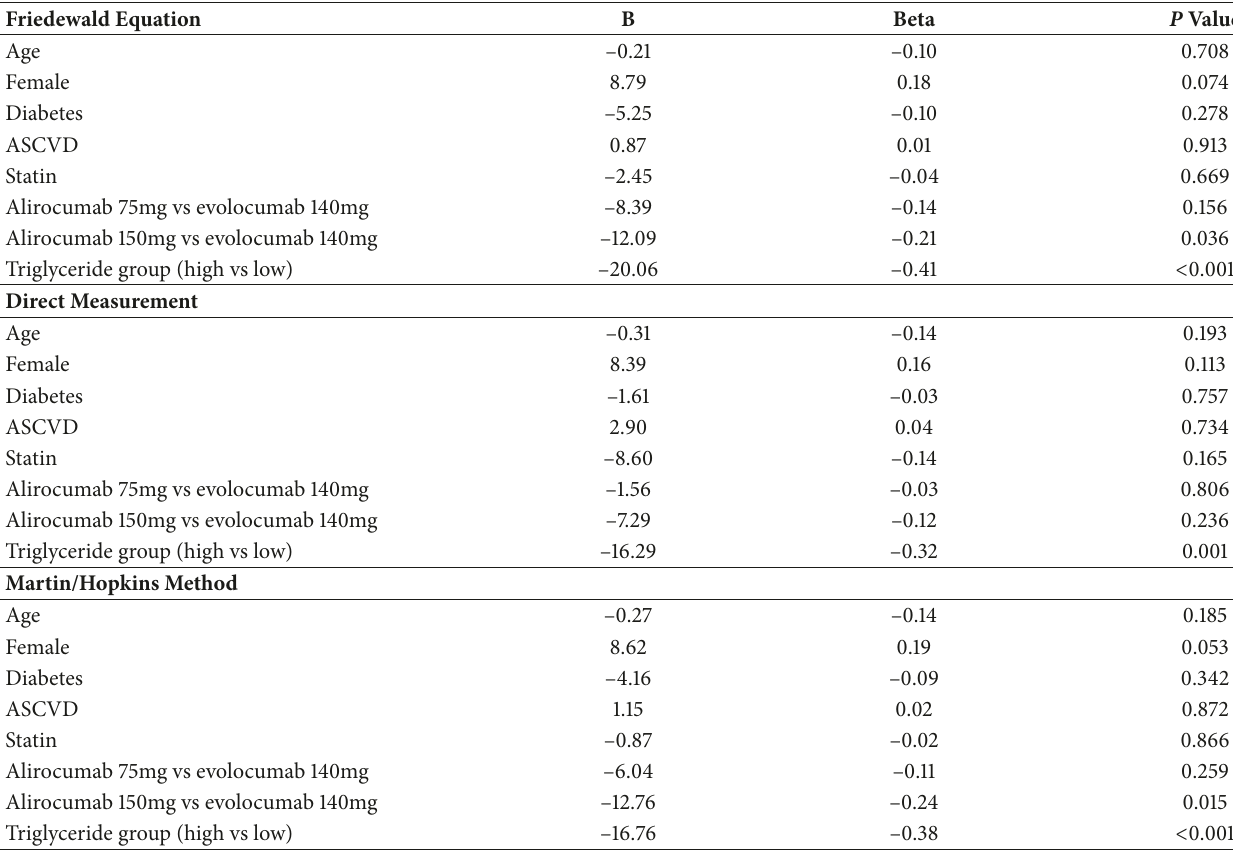
Table 3: Results of the multivariable linear regression analyses for change in remnant cholesterol when LDL was derived by 3 different